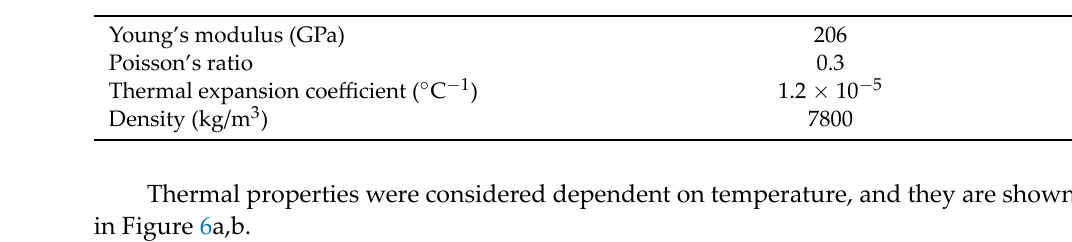
Figure 5. Geometries and dimensions for 4th and 5th passes. ( A ) The 4th and 5th geometry passes. ( B ) The 4th and 5th roll dimensions (in mm). Table 2 shows elastic properties of 1075 steel. Table 2. Elastic properties of 1075 steel.